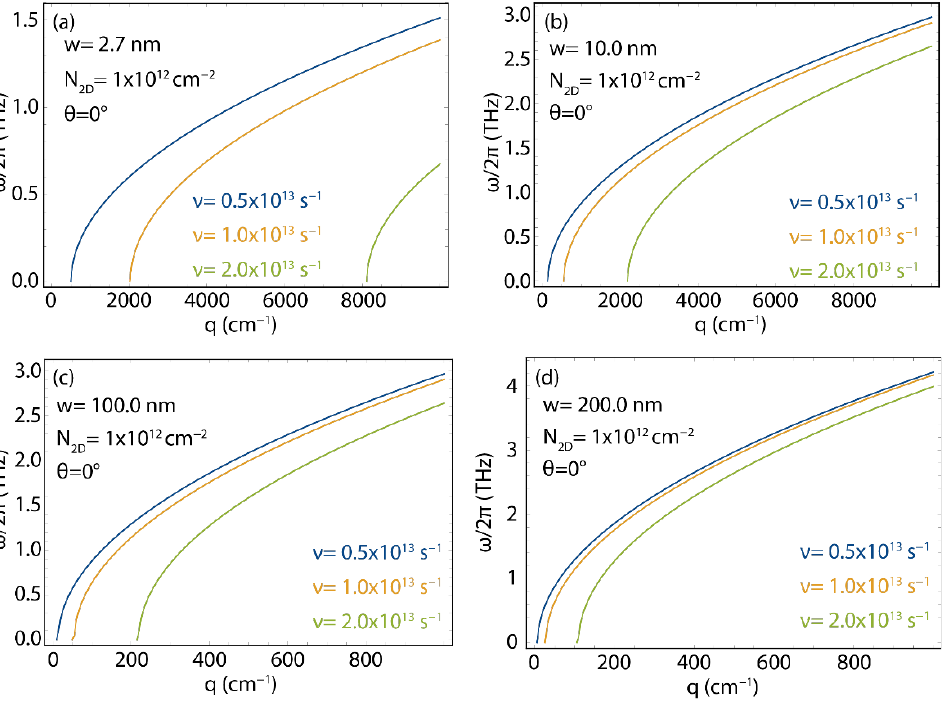
Figure 9. Plasmon energy ( 𝜔/2𝜋 ) as a function of plasmon wave vector ( 𝑞 ), as obtained using Equation (5) (with v F = 0.829 × 10 6 m/s, 𝑁 2𝐷 = 1 × 10 12 cm − 2 , and 𝜃 = 0 ) for different values of electron mobility ( 𝜈 ), considering four different ribbon widths: 𝑤 = 2.7 nm ( a ), 𝑤 = 10 nm ( b ), 𝑤 = 100 nm ( c ), and 𝑤 = 200 nm ( d ). The corresponding effective masses ( 𝑚 ∗ ) are reported in Table S4. We point out that the increment in the horizontal axis of the graphics in the bottom row is 10 times smaller than in the graphics of the top row.